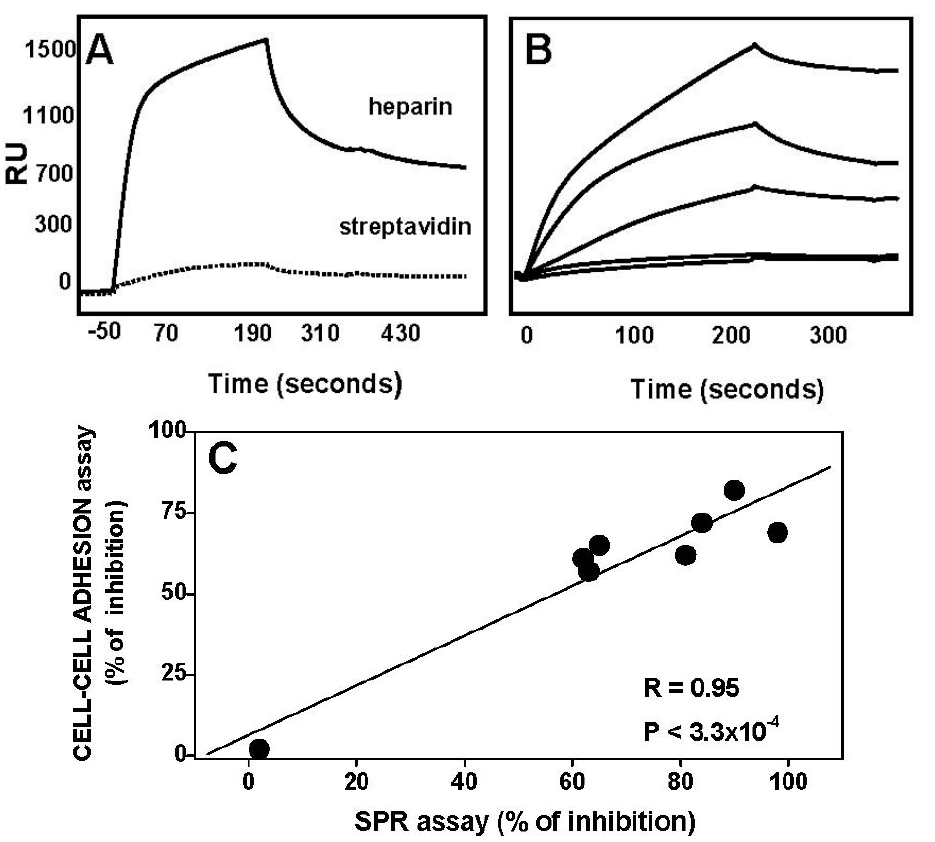
Figure 8. Capacity of LMW-K5 derivatives to prevent FGF2/heparin interaction in a SPR- based assay A) Heparin was biotinylated at its reducing end and immobilized onto a sensorchip previously activated with streptavidin. A streptavidin-activated sensorchip without biotinylated heparin was used as a negative control. FGF2 (260 nM) was injected over heparin-coated (straight lane) and control (dotted lane) sensor chips for four minutes and washed until dissociation was observed. After each run, the sensor chips were regenerated by a 2 M NaCl pulse. For further details see [94]. The response (in RU) was recorded as a function of time. Adapted from [94]. B) Sensorgram overlay showing the binding of FGF2 to immobilized heparin in the presence of increasing concentrations of free heparin. C) Different LMW-K5 derivatives were evaluated for their capacity to inhibit FGF2/heparin interaction in the SPR assay (expressed as % of inhibition when the compounds were tested at the dose of 300 nM) and to prevent HSPG/FGF2/FGFR1 ternary complex formation in the FGF2-dependent CCA assay (expressed as % of inhibition when the compounds were tested at the dose of 200 nM). Data from both CCA and SPR assays were the mean of three independent experiments (performed in duplicate for CCA